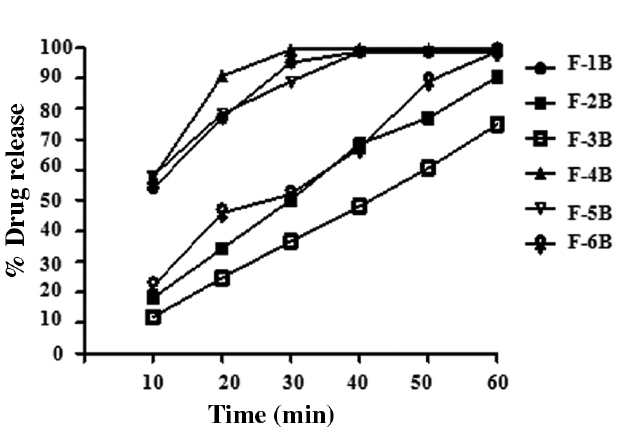
FIGURE 1 – In Vitro drug release profile of sodium diclofenac